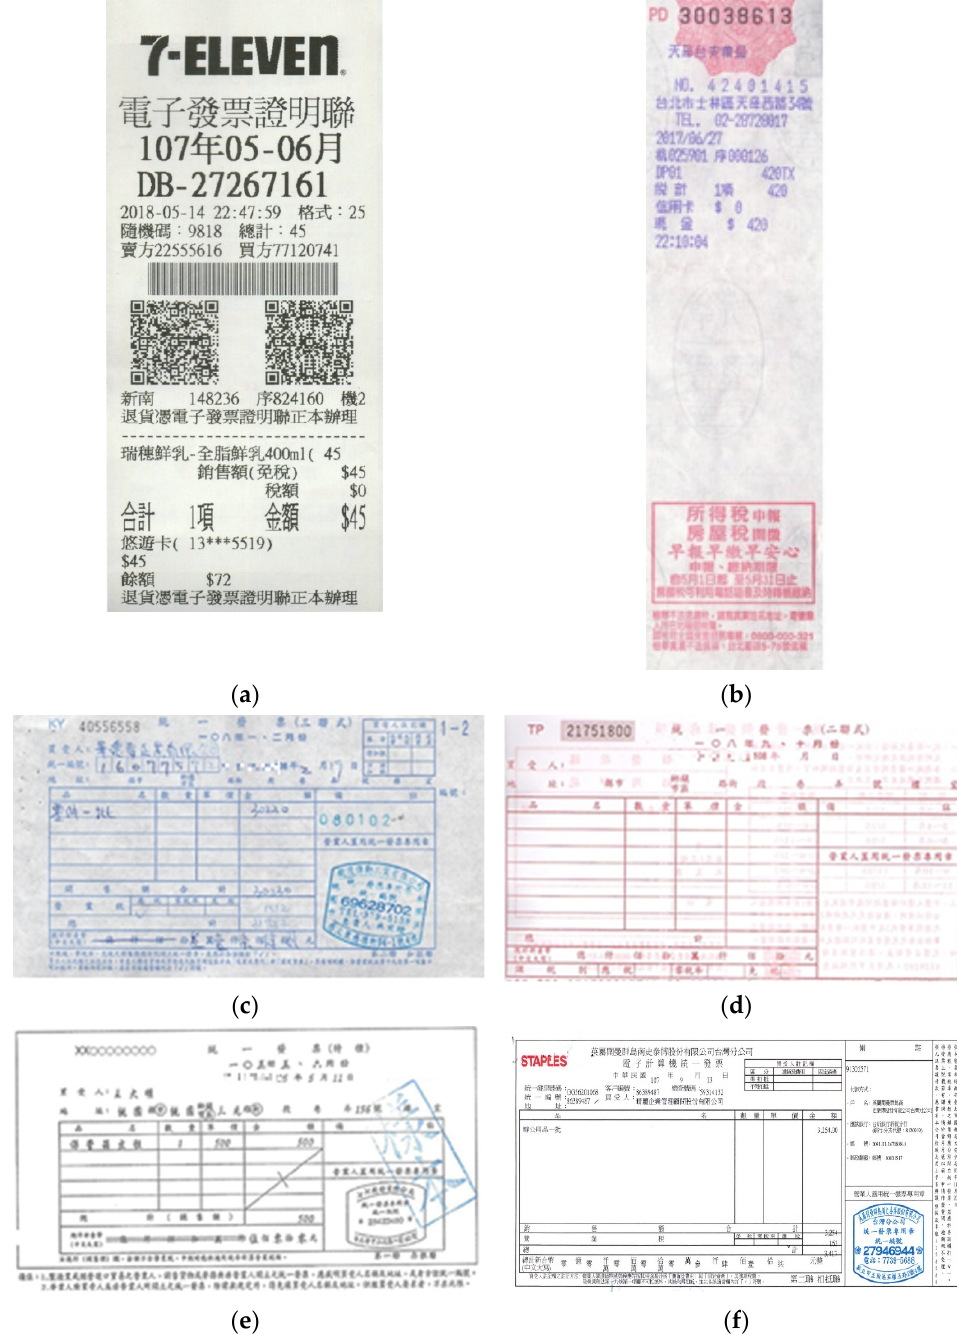
Figure 11. Various receipt formats: ( a ) electronic receipt certification sheet, ( b ) cash register unified receipt, ( c ) triple unified receipt, ( d ) double unified receipt, ( e ) special unified receipt, and ( f ) electronic computer unified receipt .